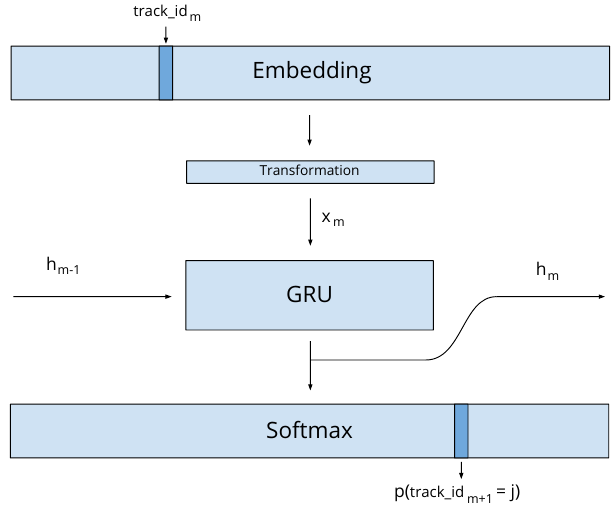
Figure 4. Expanded Gru4Rec model for Fisher embedding.